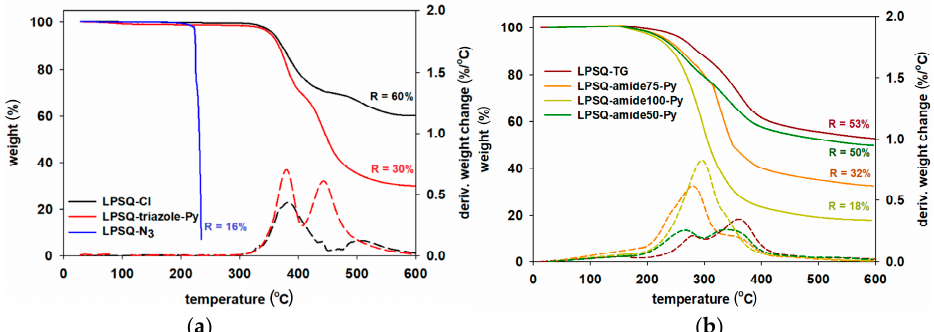
Figure 2. ATR-FTIR spectra plotted in absorbance mode (arbitrary units) of ( a ) LPSQ-amide-Py and ( b ) POSS-amide-Py along with spectra of the intermediate products.